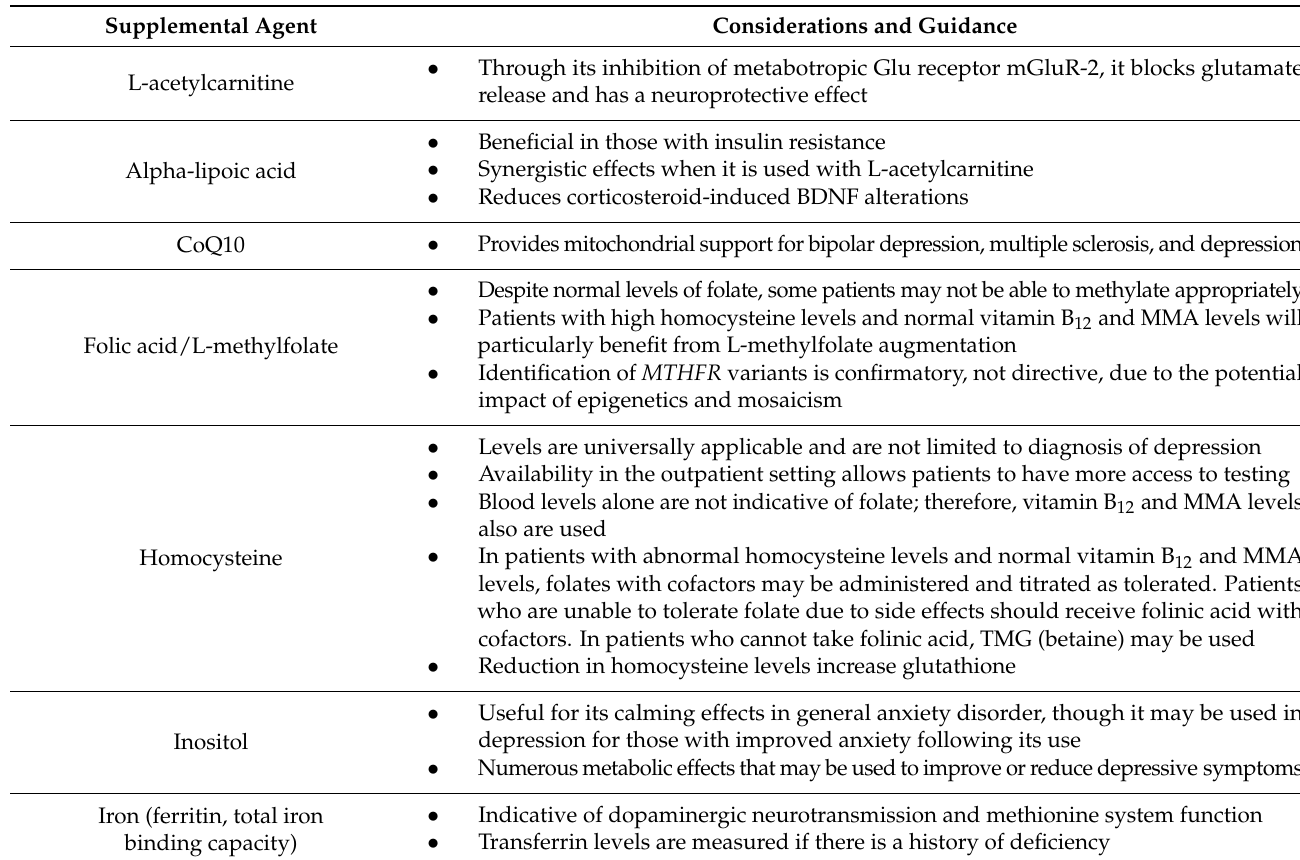
Table 2. Practical considerations for dietary approaches to management of mood